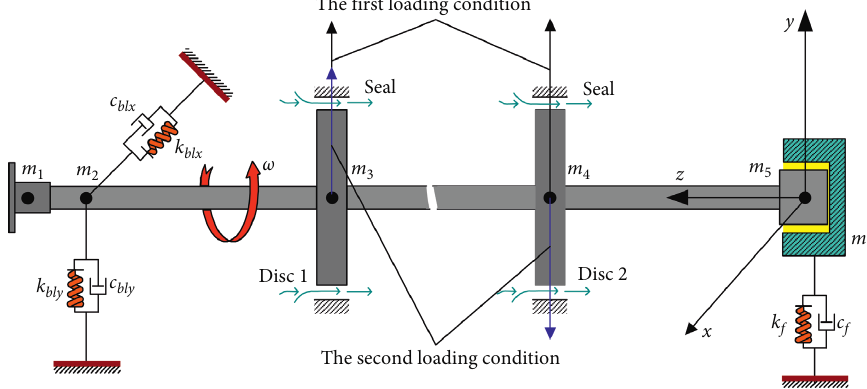
Figure 1: Mechanical model of the rotor-bearing-seal-foundation